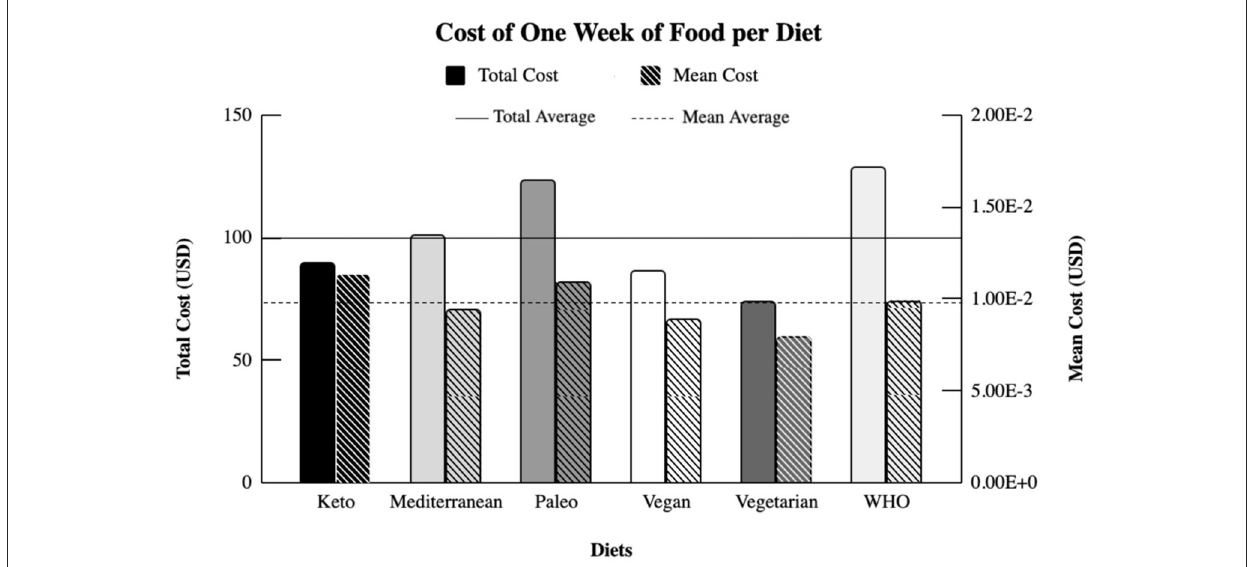
FIGURE3 Cost (in US dollars) calculated for each diet for 1 week of meals at 2,000 kilocalories/day. Total cost [( Left) Y-axis] is calculated by summing the price of all food items within a diet, adjusted to each food’s quantity in grams. The accompanying solid line shows the average total cost across all diets. Mean price [ (Right) Y-axis] is calculated by dividing a diet’s total cost by the quantity of food grams within that diet, resulting in a mean value. The accompanying dashed line shows the average mean cost across all diets. Price data was obtained from Bai et al. (2021) and provided by the World Bank’s International Comparison Program (ICP)